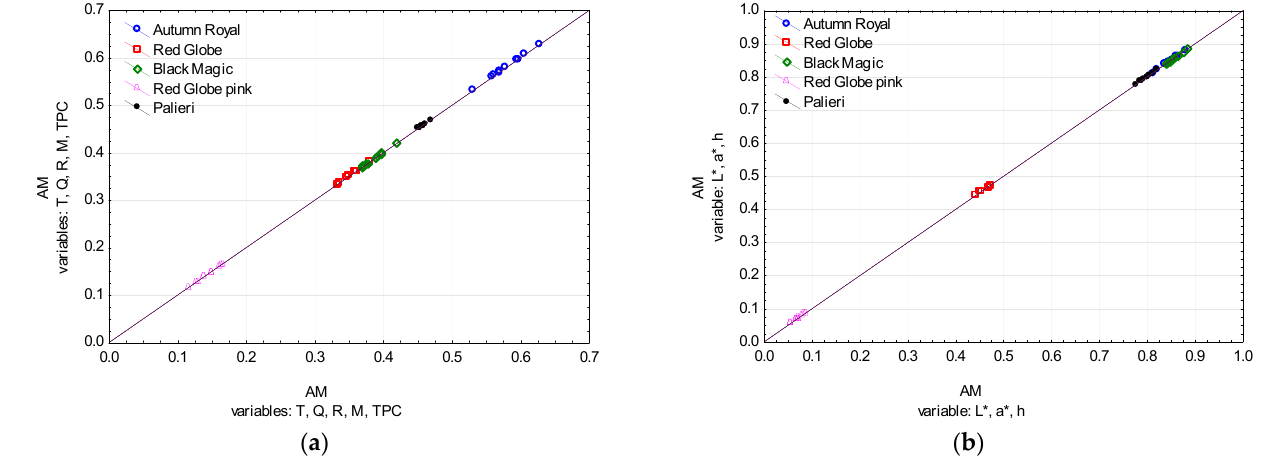
Figure 2. Graphical presentation of linear ordering of 5 objects (table grape varieties in ten replication each) based on the parameters: taxifolin—T, quercetin—Q, rutin—R, myricetin—M and total phenolic content TPC ( a ) and color coordinates: lightness—L*, redness—a*, hue angle—h ( b ).